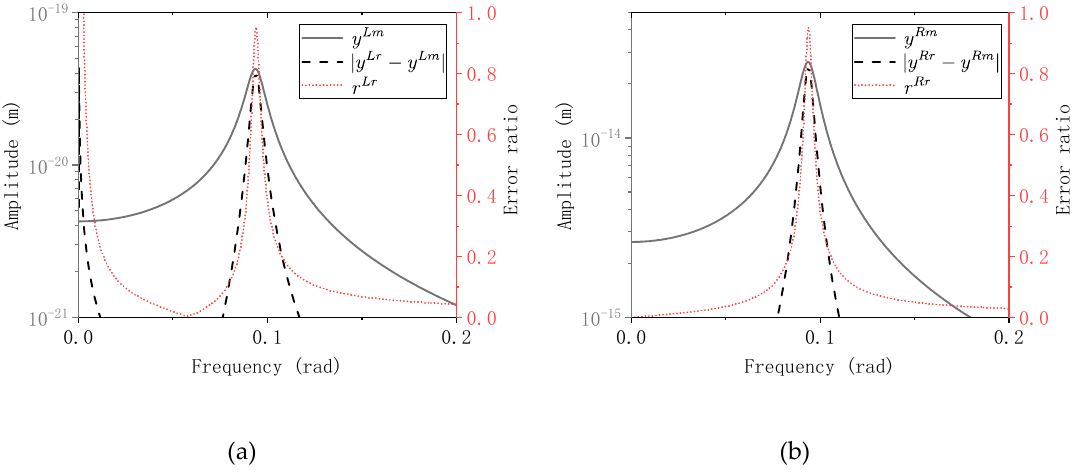
Figure 7. Frequency response function of the 4th mode when n = 20, error and error ratio for different modeling methods, ( a ) large mass method with the Rayleigh damping method (LMM-R) ( b ) relative motion method with the Rayleigh damping method (RMM-R).